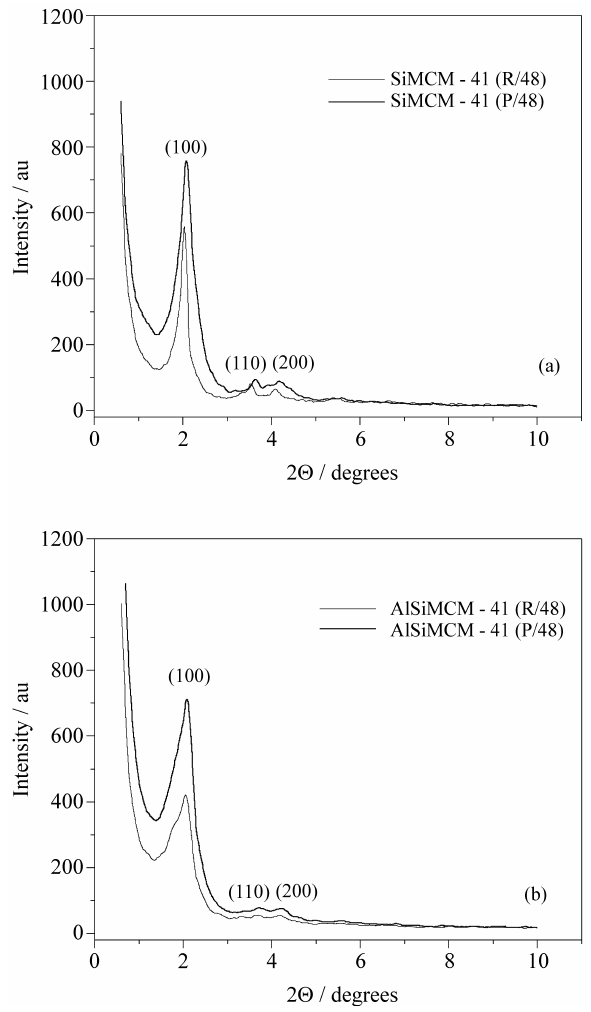
Figure 1. XRD of the as synthesized: a) SiMCM-41, and b) AlSiMCM-41